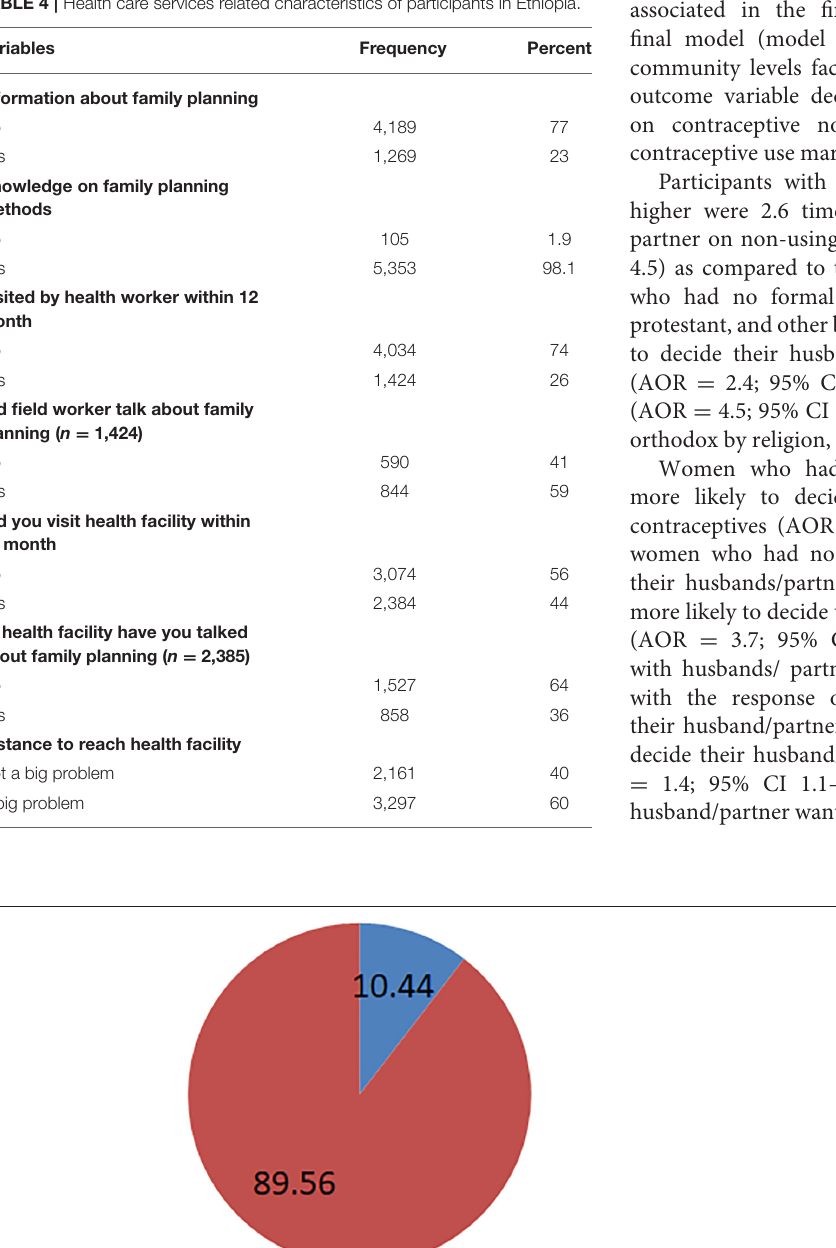
Frontiers in Reproductive Health |